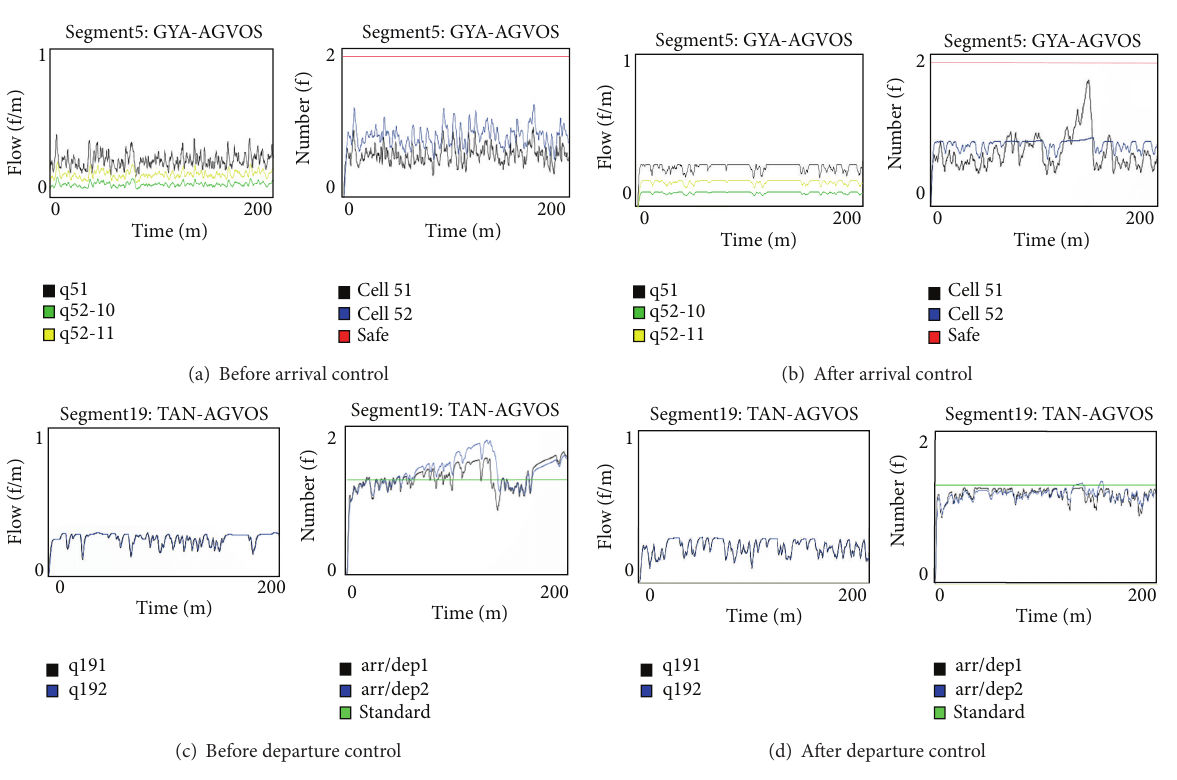
Figure 7: Comparison of traffic flux and stock over time before and after control